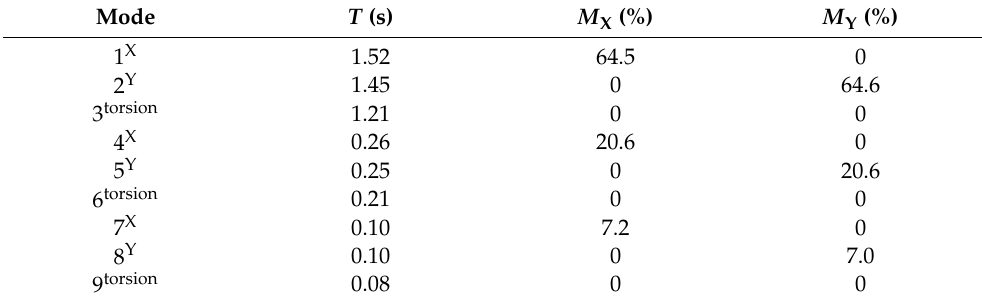
Table 1. Periods of vibration ( T ) and effective mass ratios ( M X and M Y ) for the first nine